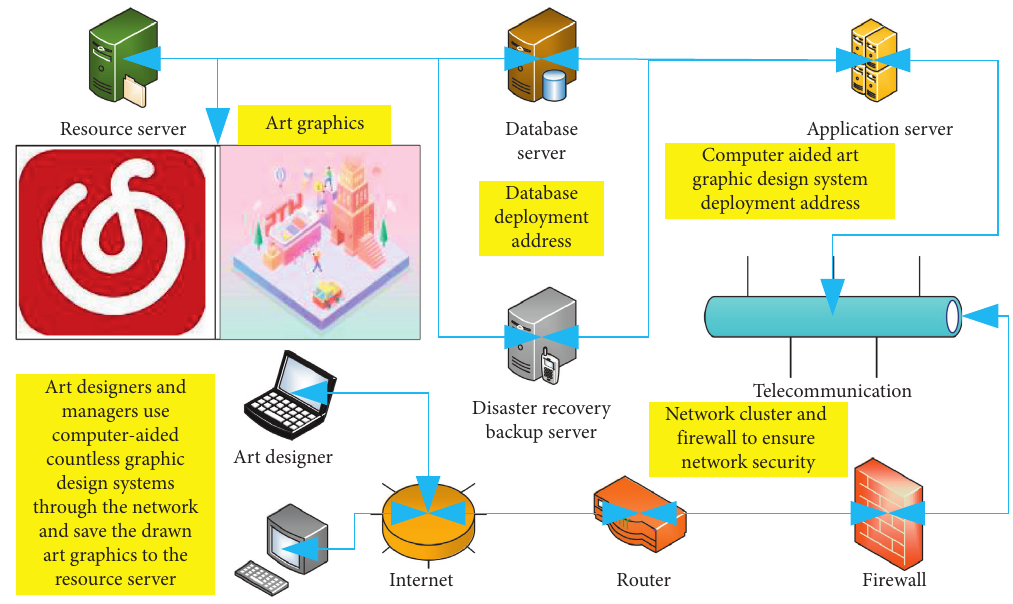
Figure 1: Overall system architecture